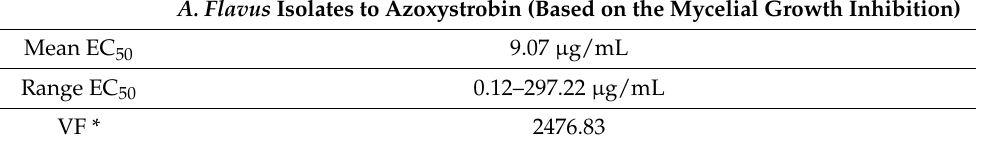
Table 1. Mean and range of effective concentration inhibiting 50% (EC 50 ) growth of A. flavus isolates.